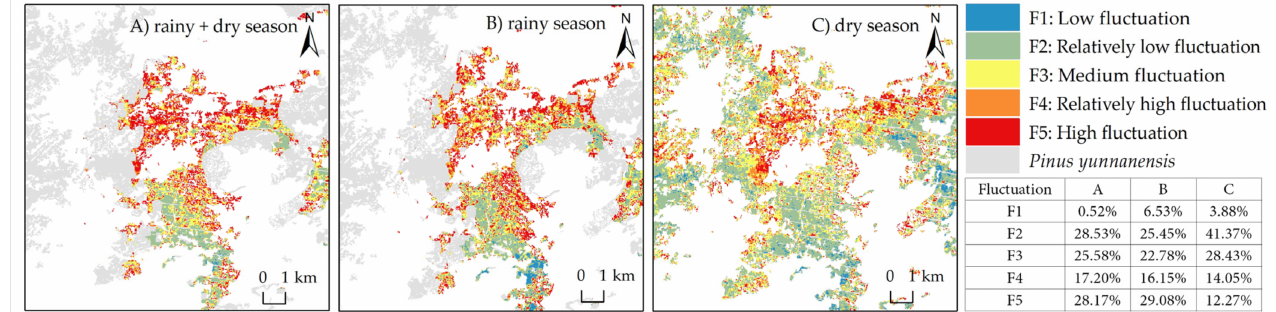
Figure 6. Spatial distribution of inter-monthly NDVI coefficients in Yunnan pine forests during the rainy season, dry season, and rainy + dry season.